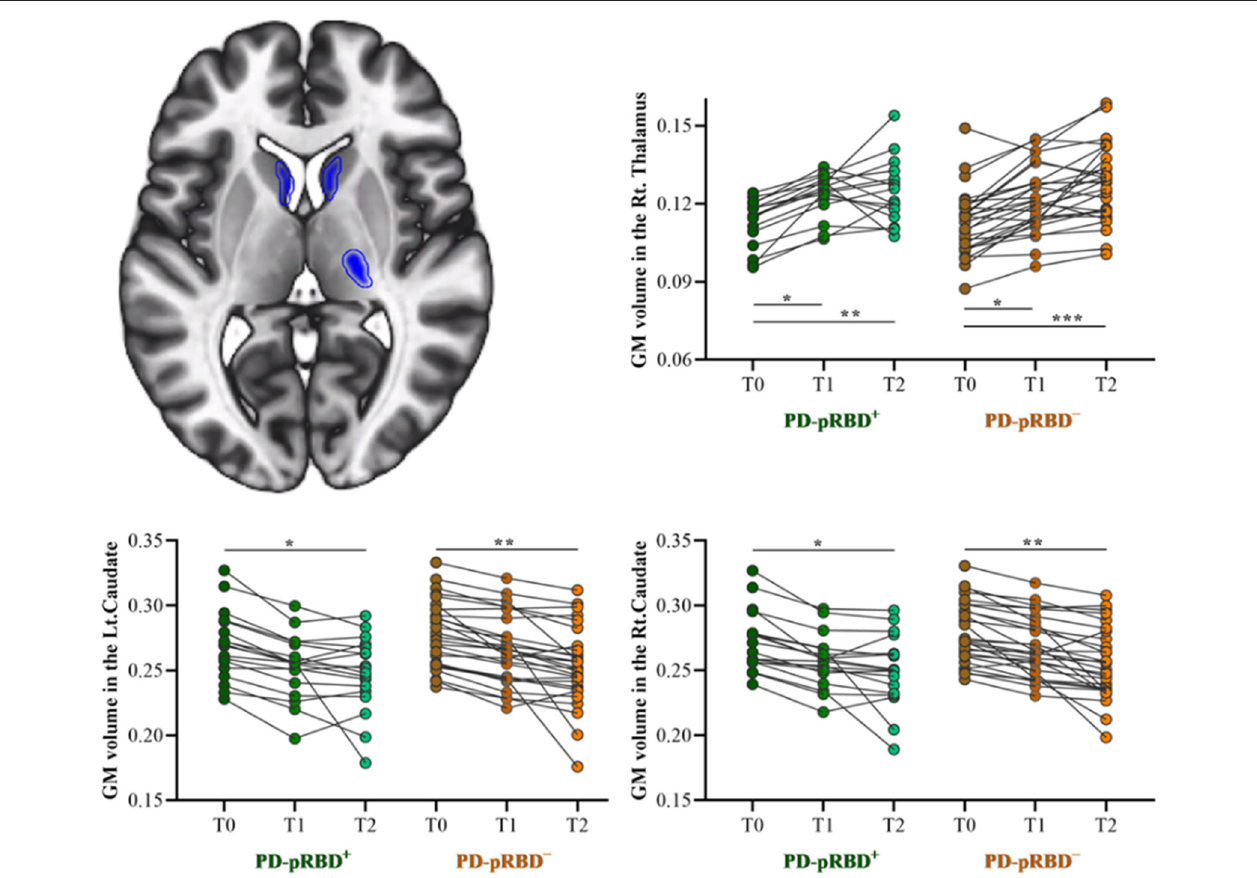
FIGURE 3 | Longitudinal GM volume changes in patients with both PD-pRBD + and PD-pRBD − over time. The results were thresholded based on a voxelwise height threshold of p < 0.05 (FWE-corrected). Mixed repeated measures analysis of variance was performed to compare the longitudinal changes between PD groups with visit-time (i.e., T0, T1, T2) as within-group factor and group (i.e., PD-pRBD + and PD-pRBD − ) as between-group factor. Post-hoc comparisons were further performed to determine longitudinal changes over time within group and differences between groups at each visit time. PD-pRBD + , Parkinson’s disease (PD) with probable rapid eye movement (REM) sleep behavior disorder (pRBD); PD-pRBD − , PD without pRBD; GMV, gray matter volume; Lt, left; Rt, right. * p < 0.05; ** p < 0.01; *** p < 0.001.